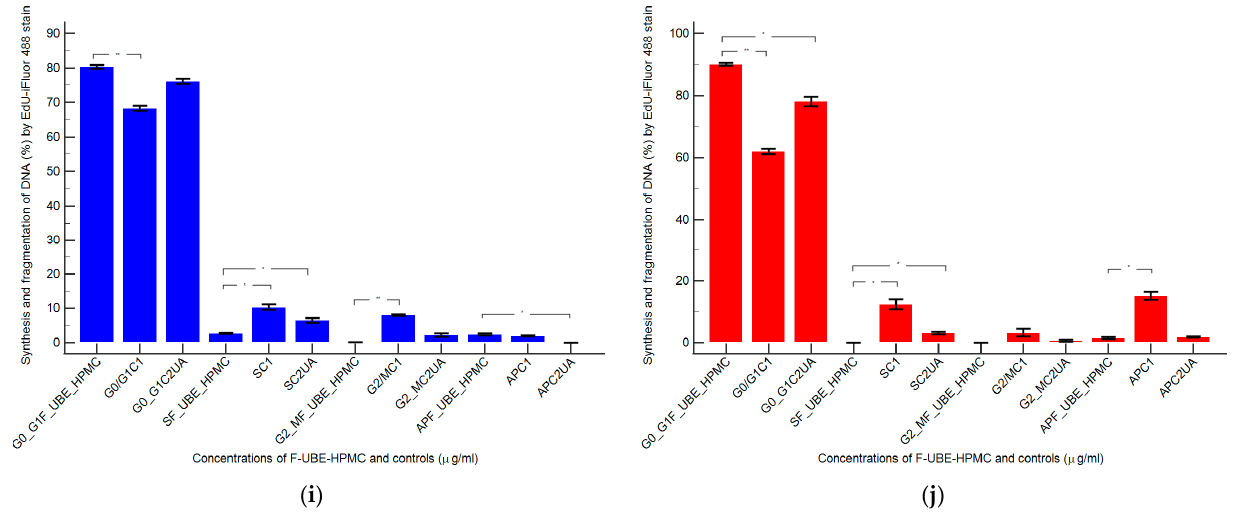
Figure 9. Synthesis (S) and fragmentation of DNA models in normal blood cells ( a – c ) and CLS-354 tumor cells ( d – f ) after 24 h treatment with F-UBE-HPMC. EdU-iFluor 488 patterns of F-UBE-HPMC ( a , d ); 1% DMSO negative control ( b , e ); 125µg/mL UA-positive control ( c , f ). F-UBE-HPMC and controls extrapolated on EdU-iFluor 488 axis ( g , h ); AP—apoptotic cell fraction (sub G0/G1); F-UBE-HPMC—mucoadhesive oral patches loaded with U. barbata (L.) dry ethanol extract. Statistical analysis ( i,j ) of DNA synthesis (S) and fragmentation (AP—apoptotic cell fraction, sub G0/G1 phase) in normal blood cell cultures ( i ) and CLS-354 tumor cell lines ( j ). * p < 0.05 and * * p < 0.01 underlines significant statistical differences between both controls and F-UBE-HPMC made by paired samples t -test; F-UBE-HPMC—mucoadhesive oral patches loaded with U. barbata (L.) dry ethanol extract; C1—negative control with 1% dimethyl sulfoxide (DMSO); C2UA—positive control with 125 µg/mL usnic acid (UA).